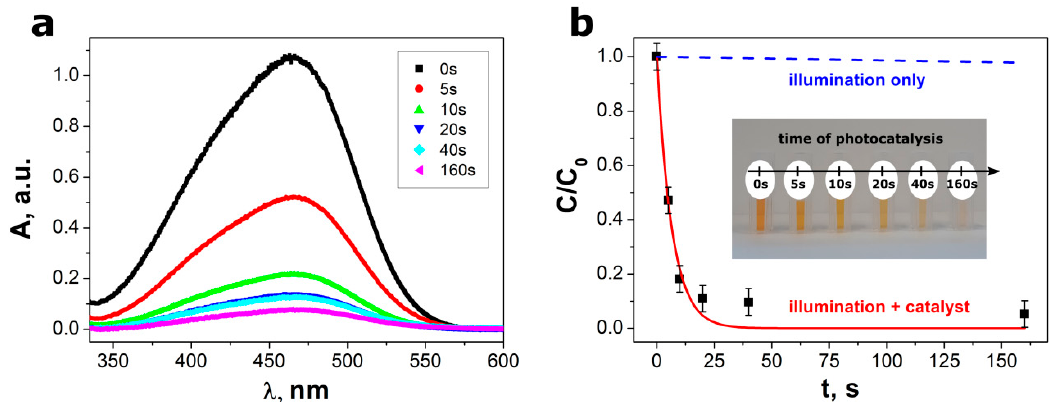
Figure 7. ( a ) An influence of photocatalysis time on UV–vis absorption spectra and ( b ) relative concentrations (C / C 0 ) of the MO aqueous solutions. Red line in graph ( b ) represents the best fitted dependence described by Equation (1). Blue dashed line in graph ( b ) shows data registered in control experiments conducted under light illumination without SbSI photocatalyst. The inset in graph ( b ) presents decoloration of MO solution with increase of photocatalysis time. Table 2. The values of reaction kinetics rate constants for photocatalytic decomposition of methyl orange using various materials (used abbreviations: m ph / m MO —the ratio of photocatalyst mass to the initial mass of methyl orange in aqueous solution; MRs—micro-rods; NCs—nanocrystals; NPs—nanoparticles; NRs—nanorods; NSs—nanosheets; NWs—nanowires; t ph —time of photocatalysis; η —degradation efficiency). Ag 2 O / Ag 2 CO 3 AgBr / graphene 240